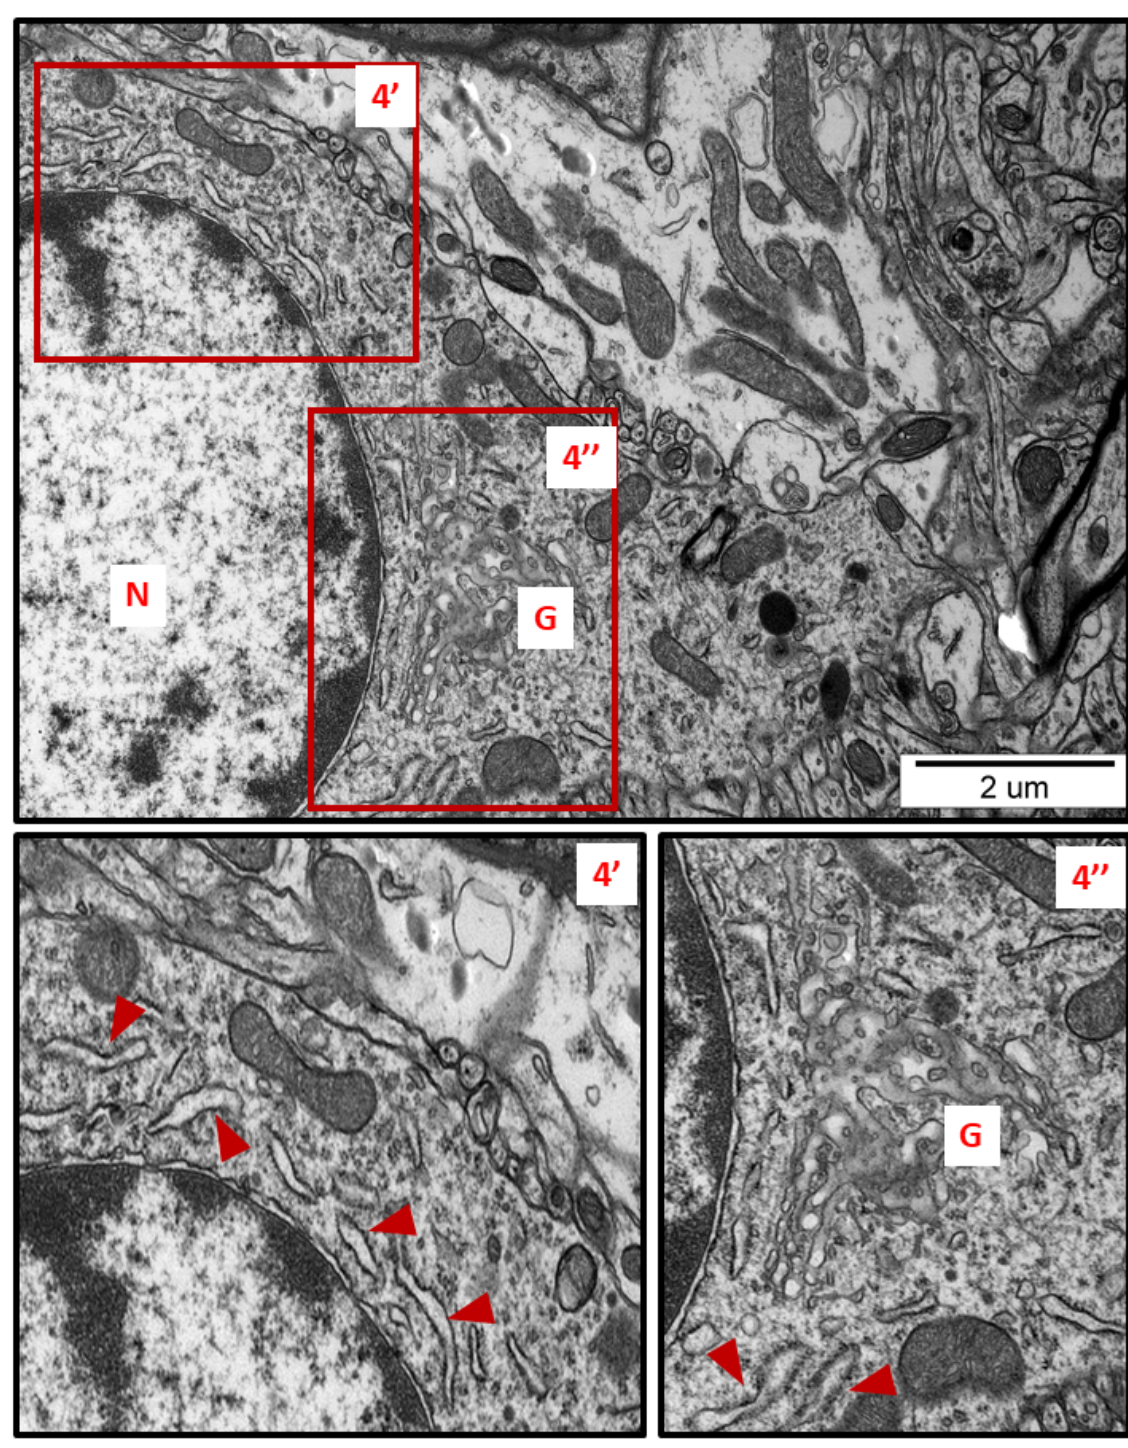
Figure 4. Representative TEM micrograph from brain tissue of AgNP-exposed animals showing swollen fragments of RER (arrowheads) and enlarged Golgi complex (G); N—nucleus. Insets (4 ′ , 4 ″ ) were magnified 2×. Images typical for 3 animals per group.